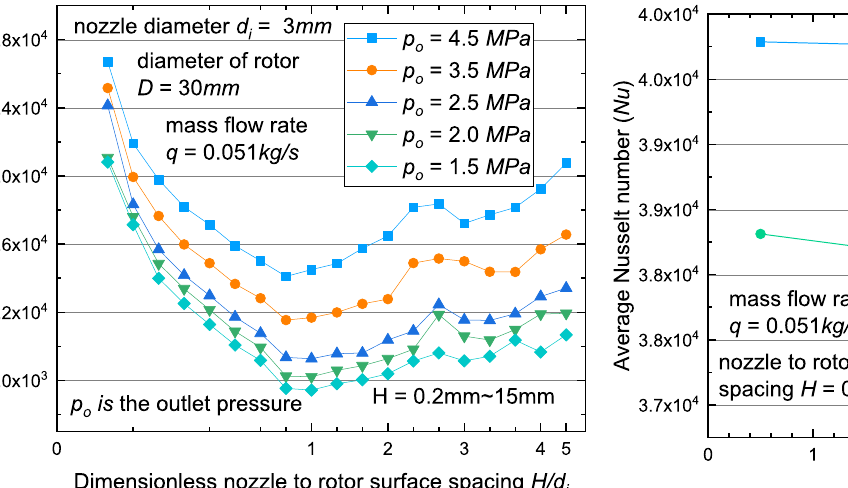
Fig. 10. Comparison of the Nu between d i = 5 mm and d i